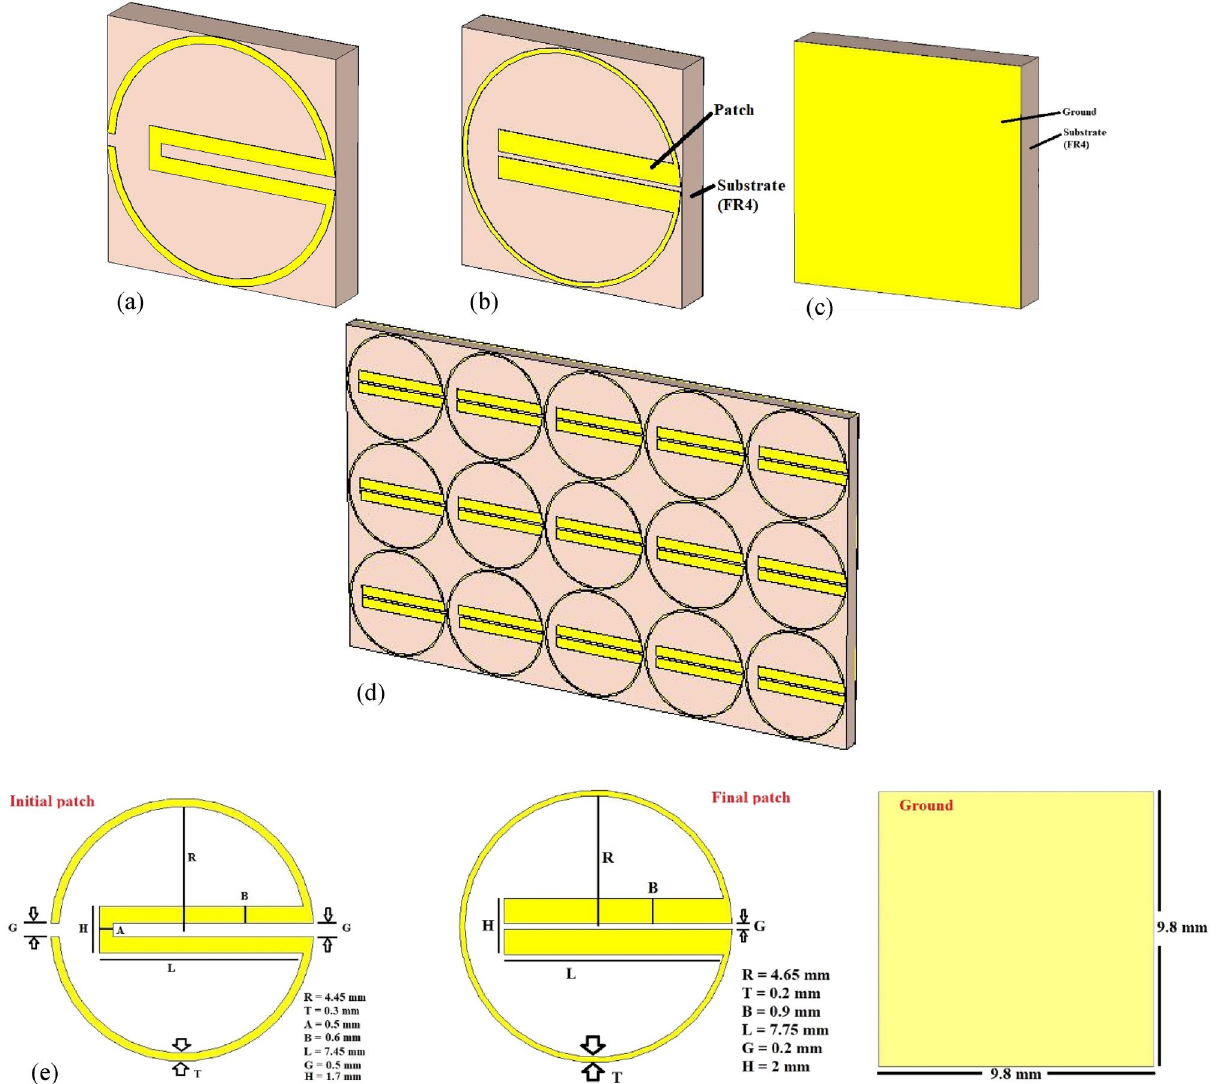
Figure 1. Design of the proposed metamaterial ( a ) initial patch of the unit cell (unit cell-1), ( b ) finalized patch of the unit cell (unit cell-2), ( c ) ground of the unit cell, and ( d ) array structure (3 × 5) for 5G mobile phone. ( e ) Dimension of the patch and the